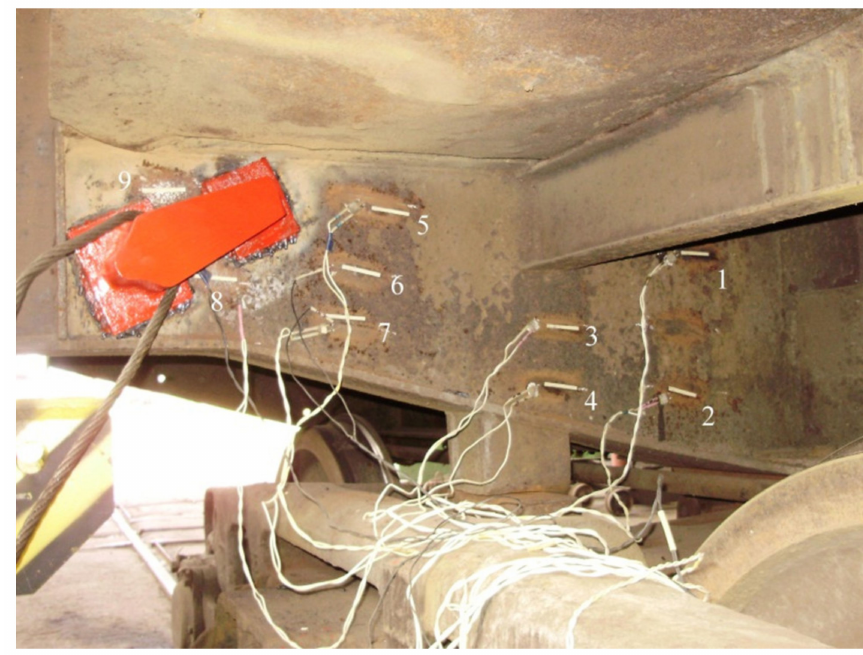
Figure 16. Location of strain gages on the vertical sheet of the bolster beam of a car. The strain gages were arranged as a Wheatstone bridge. A compensating strain gage was mounted on the homogeneous non-deflecting plate (09Mn2Cu) of a car body (Figure 17). The strain gages were connected in the electric diagram with the 0.5 mm 2